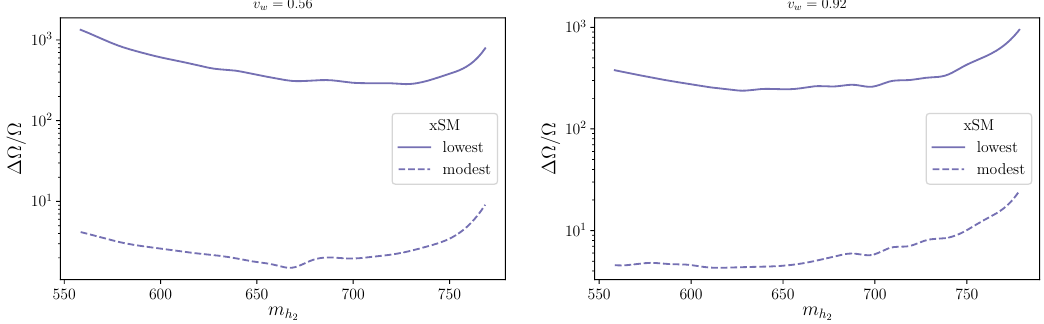
Figure 12 . Dark RG : the relative error when using the lowest and modest levels of diligence, compared to the highest level of diligence (for which ∆Ω / Ω = 0 ). The vertical axis shows the peak (frequency-independent) gravitational wave energy density for detonation. The precise defini- tion of ∆Ω / Ω is given in eq. (4.1). The horizontal axis corresponds to the heavy singlet mass . ∆Ω / Ω is displayed for deflagration and detonation at different levels of diligence using m h 2 eq. [(2.7), (2.15), (2.61)] and eq. (4.1). The temperatures are set to T